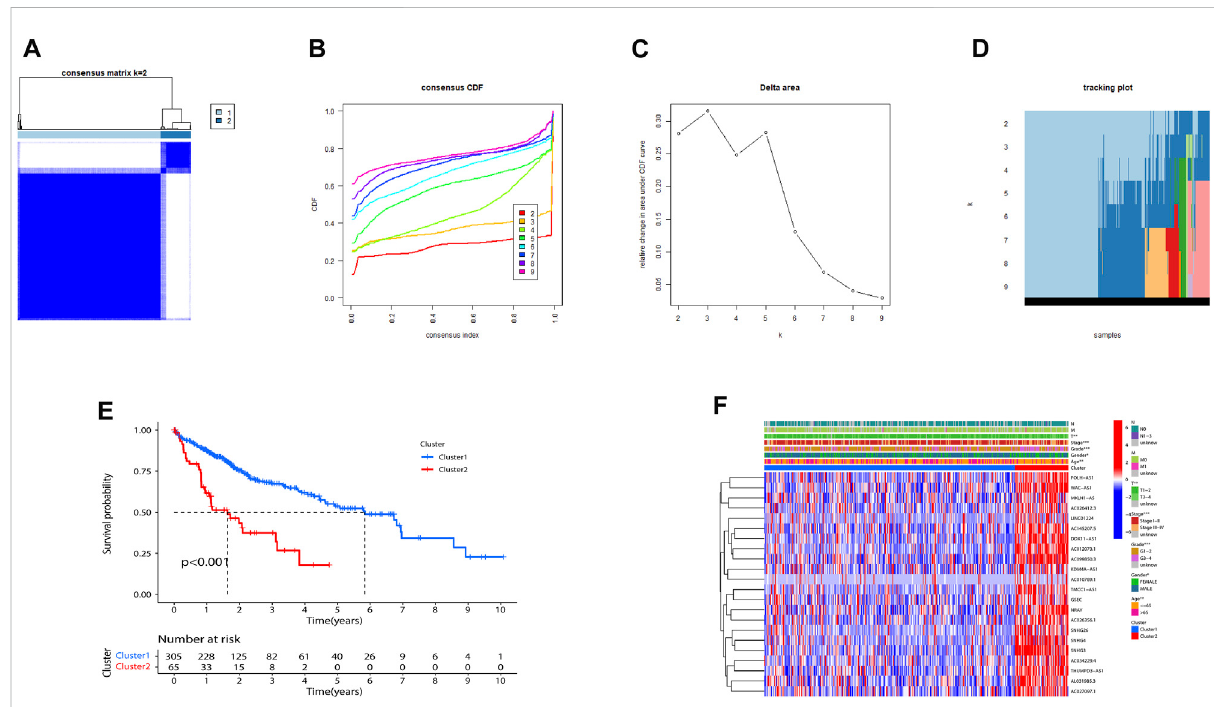
FIGURE 2 Consensusmatrix of prognostic m7G-related lncRNAs. (A – D) Consensus clustering matrix for k = 2. (E) Kaplan – Meier of overall survival for the two different clusters of HCC patients. (F) Heatmap of Cluster1 and Cluster2 with clinicopathological features and expressions of 22